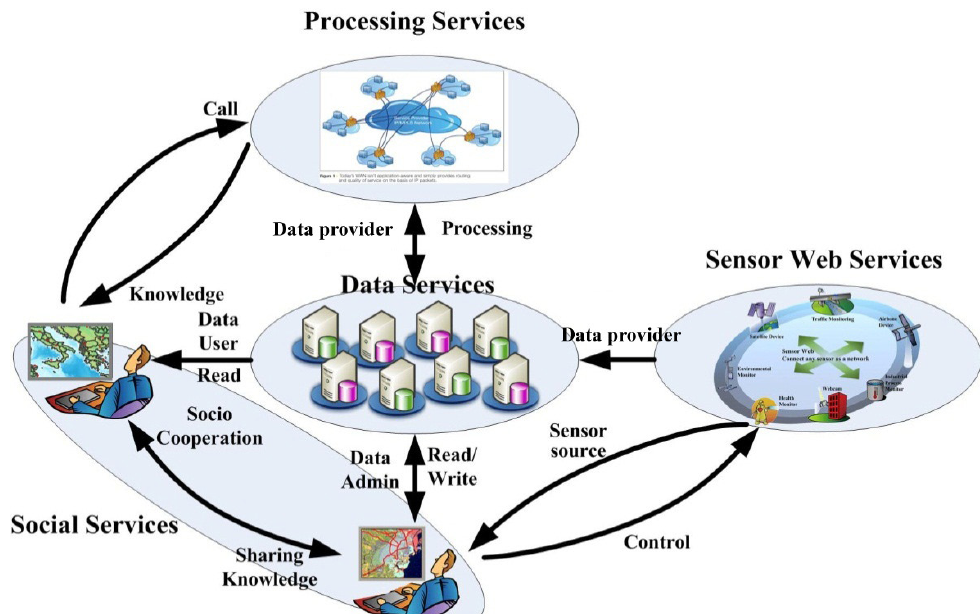
Figure 2. Linked services in